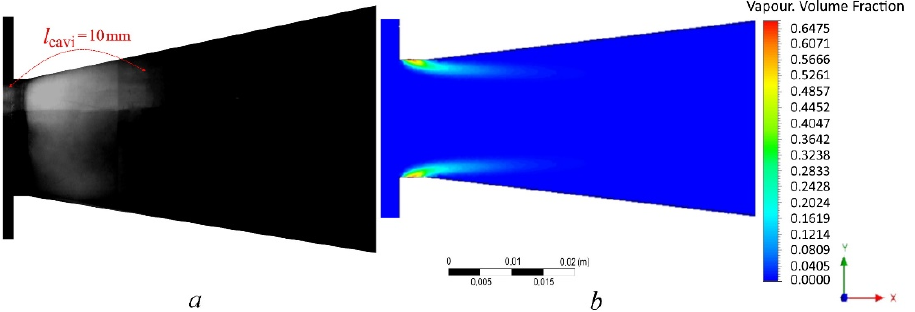
Figure 12. Numerical and experimental results. Diverging nozzle. Inlet pressure 1.8 atm. ( a ) experimental result, ( b ) CFD result.